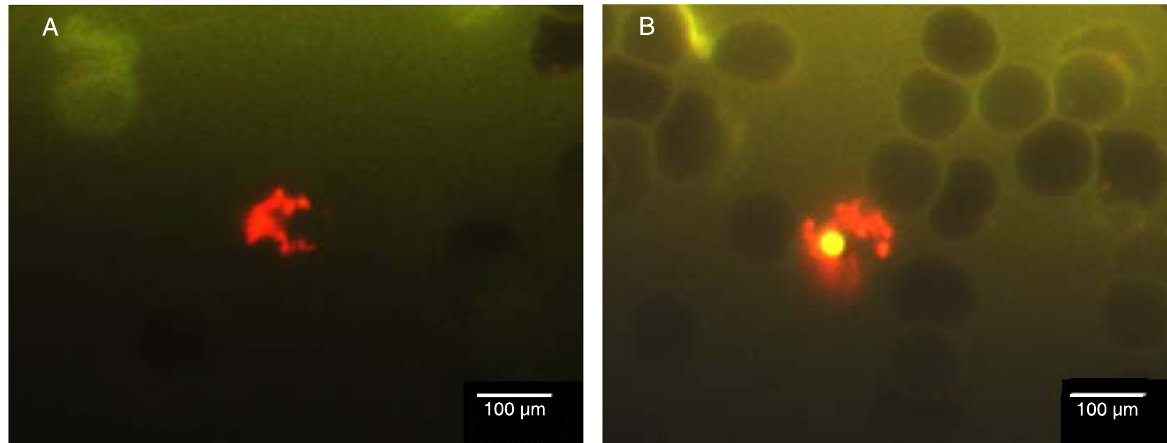
Figure 1. Reticulocyte stained with acridine orange (A) and reticulocyte-containing micronucleus